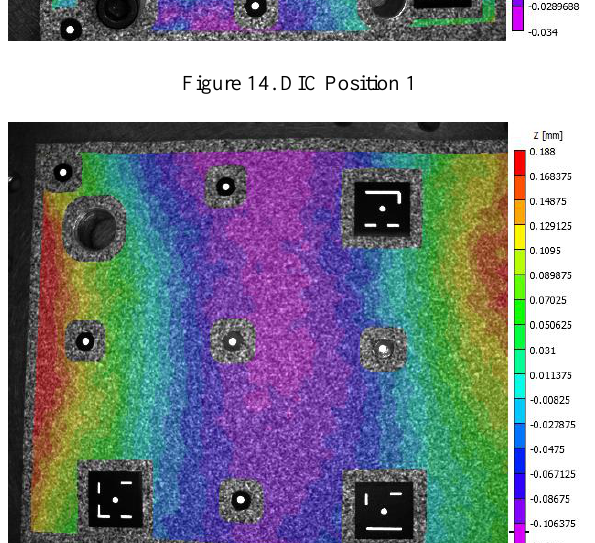
Figure 16. Deviation of relative camera position, in mm, and rotation, in degrees compared to mean point deviations in mm, indirect